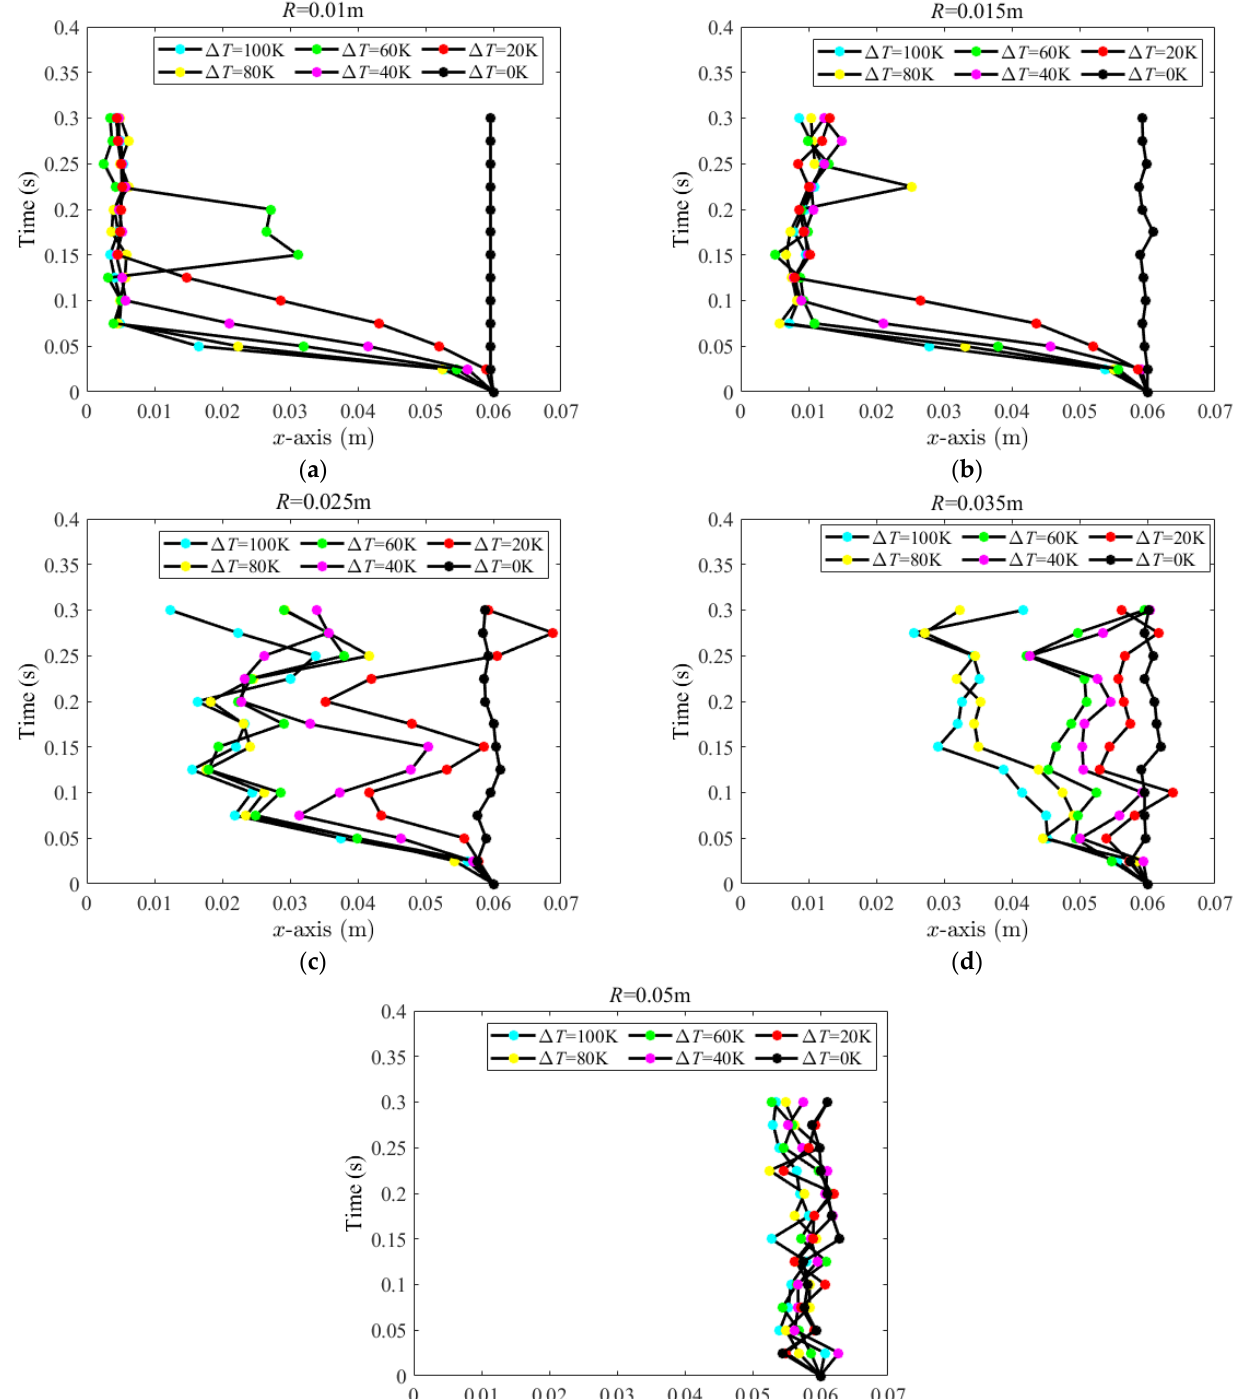
Figure 4. Schematic representation of centroid positions of bubble along the x -axis with different bubble radii of ( a ) R = 0.01 m, ( b ) R = 0.015 m, ( c ) R = 0.025 m, ( d ) R = 0.035 m and ( e ) R = 0.05 m.